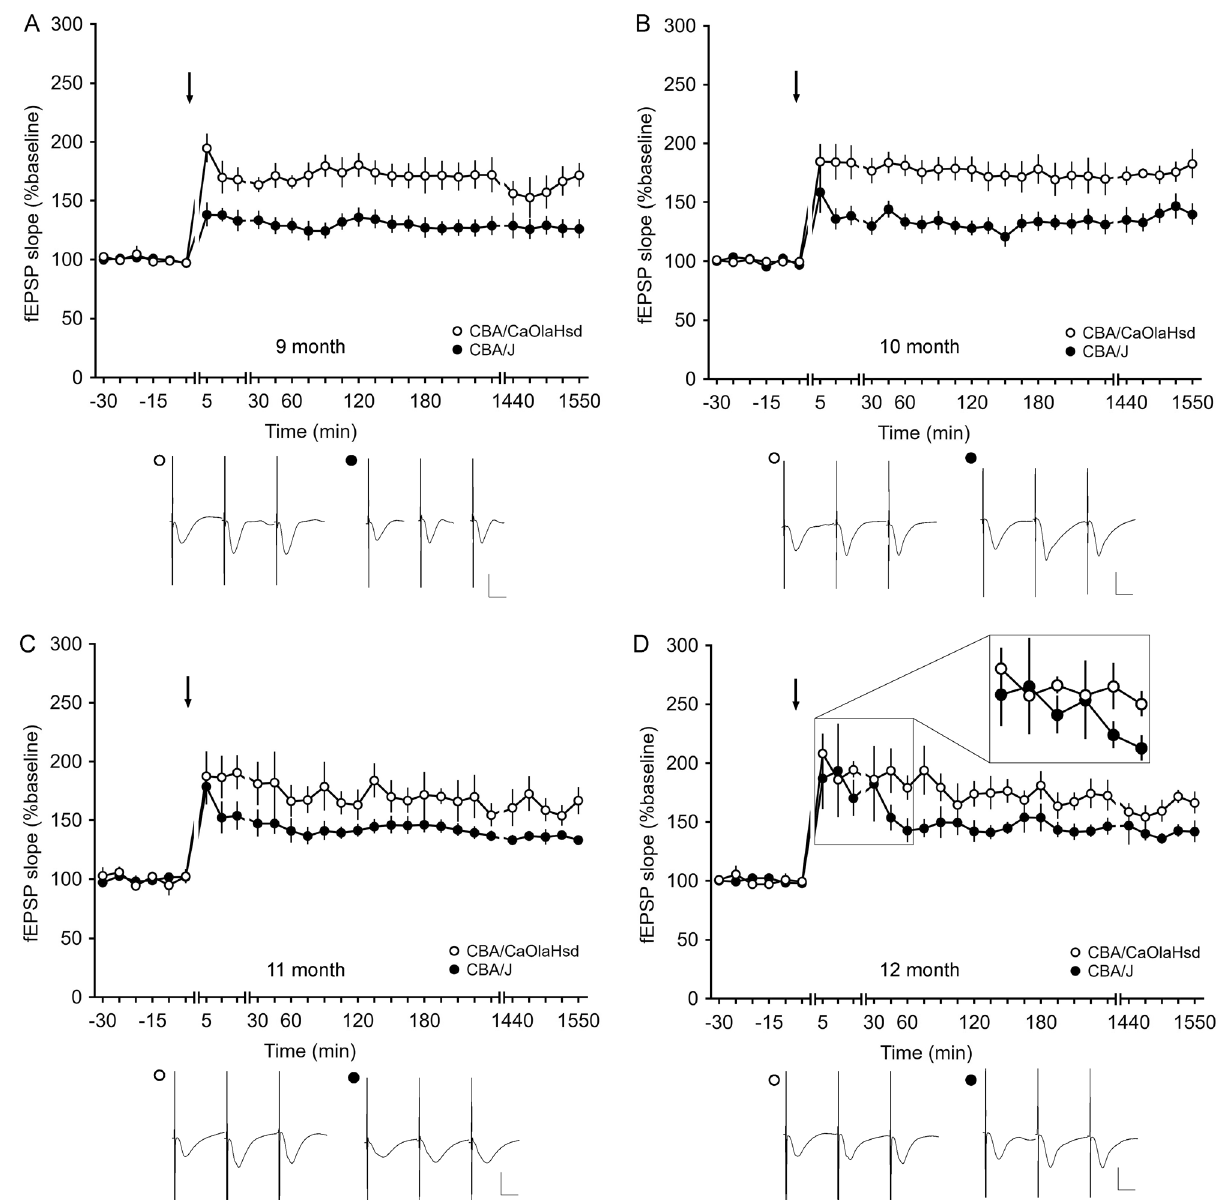
Figure 7. Comparison of hippocampal long-term potentiation of CBA/CaOlaHsd and CBA/J mice 9–12 months after birth. After application of HFS (4 × 50 pulses at 100 Hz), LTP was obtained in CBA/ CaOlaHsd and CBA/J mice that lasted over 24 h. CBA/CaOlaHsd mice showed significantly larger LTP compared to CBA/J (blind) mice, ( A ) 9, ( B ) 10 and ( C ) 11 months after birth. ( D ) At 12 months of age, LTP elicited in CBA/CaOlaHsd mice is still more potent compared to C57BL/6 mice, although a recovery of the early component of LTP became evident. The inset shows a magnification of the first six time-points after stimulation. Line breaks indicate change in time scale. Arrows depict the time of stimulation. Analogs represent responses before stimulation, after stimulation and 24 h after stimulation in CBA/CaOlaHsd (open circle) and CBA/J (closed circle) mice. Vertical scale bar: 2 mV; horizontal scale bar: 10